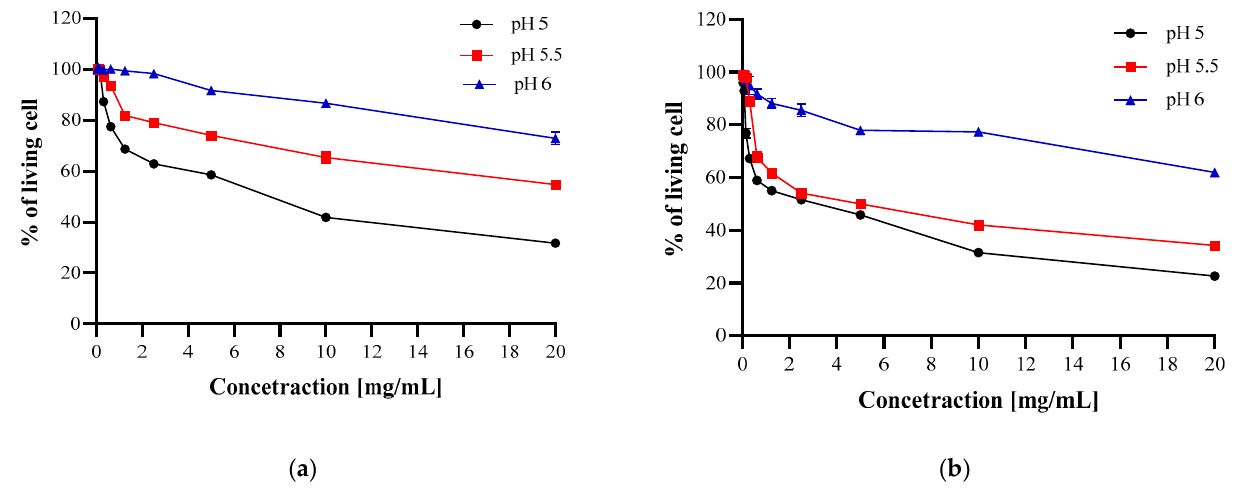
Figure 6. Antibacterial properties of CH ( a ) or CH_LA ( b ) against H. pyroli at different pH.